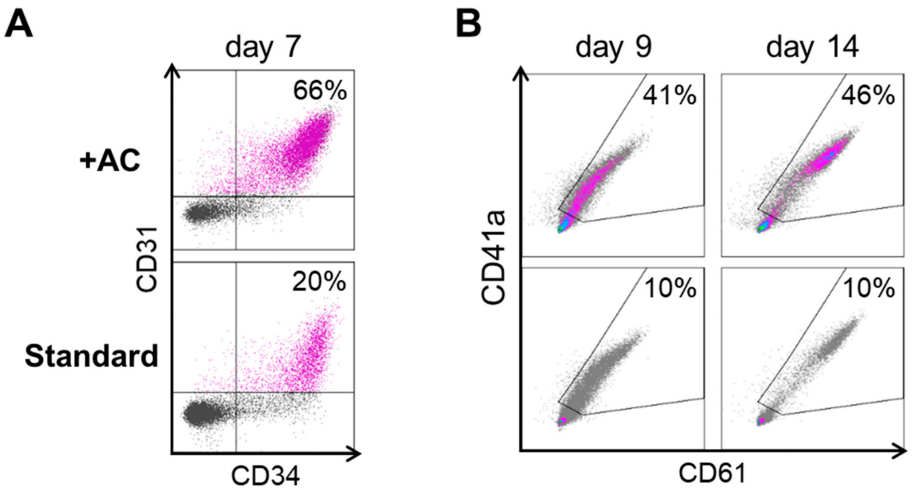
Figure A1. Representative flow cytometry plots of ( A ) hiPSC-derived HECs corresponding to Figure 1B day 7 reporter staining and ( B ) MKPs.